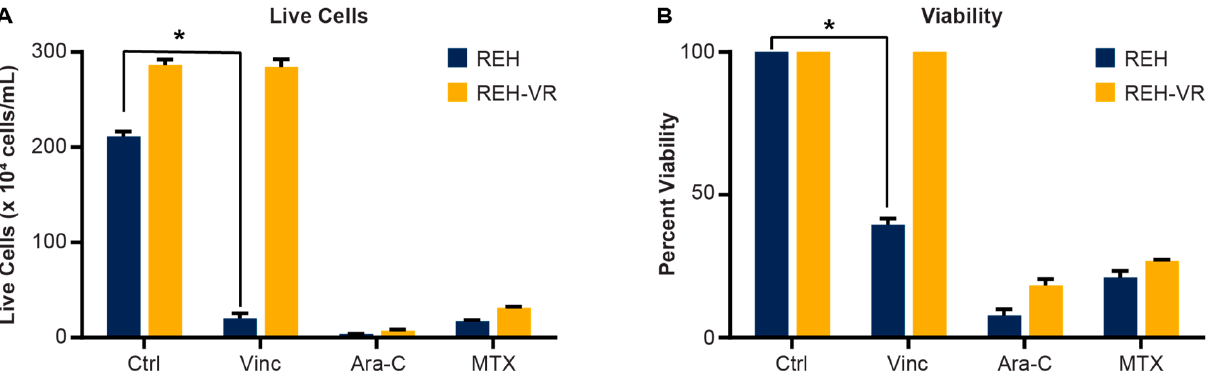
Figure 1. Development of a vincristine-resistant REH cell culture model. REH cells were cultured in the presence of increasing concentrations of vincristine to select for a vincristine-resistant cell line (REH-VR). The REH and REH-VR cells were treated with DMSO vehicle control (Ctrl), vincristine (Vinc; 2 nM), cytarabine (Ara-C; 1 µ M) or methotrexate (MTX; 4.5 nM). A Trypan Blue exclusion assay shows the ( A ) number of live cells and ( B ) percent viability where the data have been normalized to the DMSO control viability set at 100% following treatment. While the REH-VR cells showed resistance to vincristine, they were still sensitive to other standard of care agents Ara-C and MTX. Each bar is an average ± S.D., where n = 3; * p < 0.05 denotes statistical